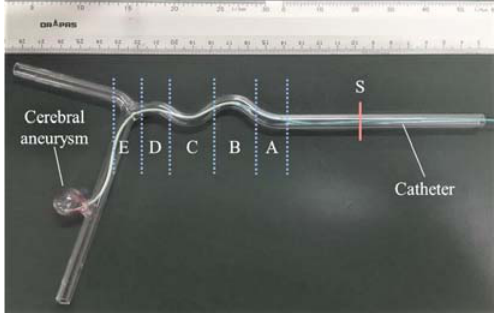
Figure 16. Rigid model of cerebral vascular.